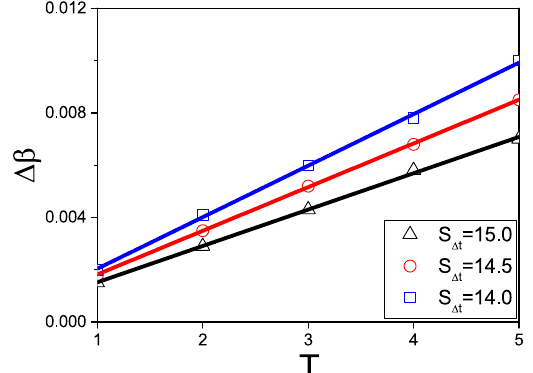
Figure 4. The relationship between Δ β and T for fixed S Δ t where the curves with “squares”, “circles” and “triangles” represent the cases of S Δ t = 14.0, 14.5 and 15.0, respectively.